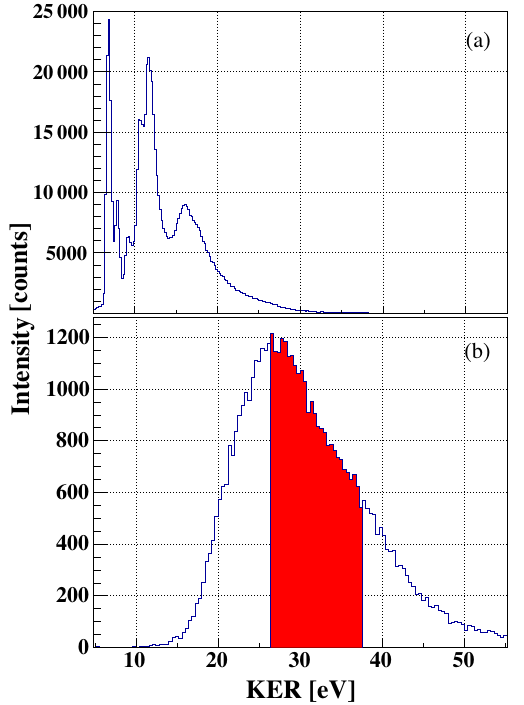
FIG. 7. Measured kinetic energy release distribution of mole- cules ending in (a) the doubly charged O þ = O þ final state and (b) the quadruply charged O þ = O 3 þ final state. The red-marked area in (b) depicts the region of KER which is used to generate the angular distributions shown in Fig.